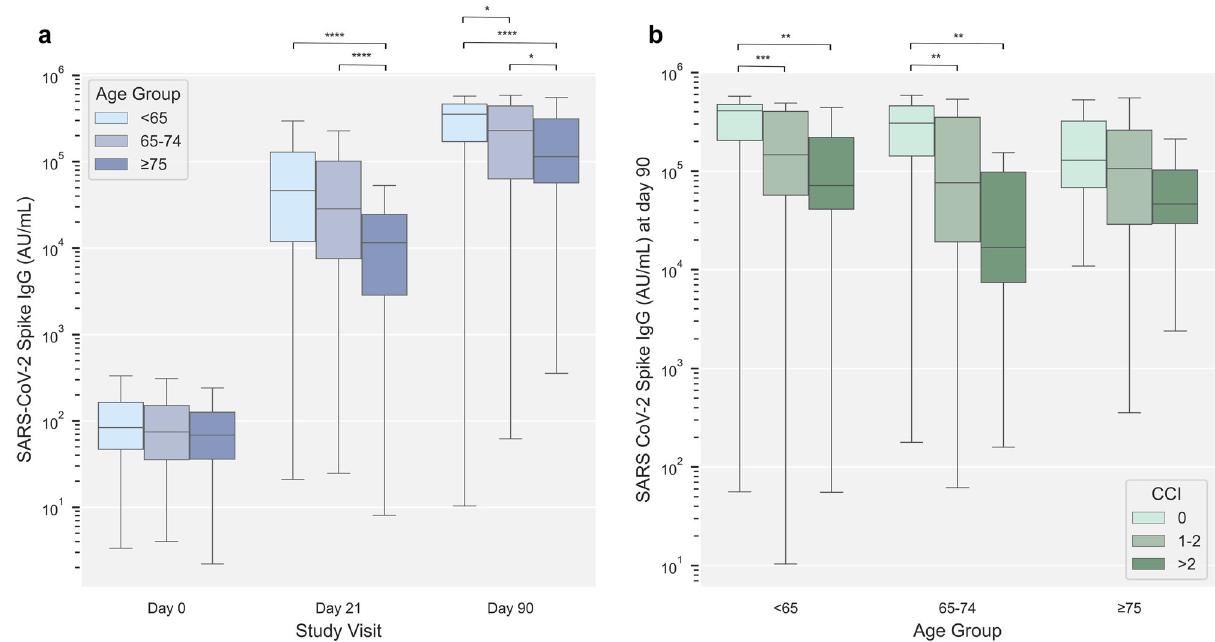
Fig. 3 SARS-CoV-2 Spike IgG by age and Charlson Comorbidities Index (CCI). a SARS-CoV-2 Spike IgG arbitrary units (AU)/ml at day 0, 21, and 90 strati fi ed by age group (<65 years [light blue], 65 – 74 years [blue], ≥ 75 years [dark blue]). Group sizes are; at day 0 n = 352 (<65 years), n = 154 (65 – 74 years), n = 144 ( ≥ 75 years); at day 21 n = 304 (<65 years), n = 152 (65 – 74 years), n = 142 ( ≥ 75 years); at day 90 n = 238 (<65 years), n = 146 (65 – 74 years), n = 139 ( ≥ 75 years). b SARS-CoV-2 Spike IgG at day 90 in the three age groups strati fi ed by Charlson Comorbidity Index (CCI) (CCI = 0 [light green], CCI = 1 – 2 [green], CCI > 2 [dark green]). Group sizes are; in age group <65 years n = 195 (CCI = 0), n = 33 (CCI = 1 – 2), n = 10 (CCI > 2); age group 65 – 74 years n = 92 (CCI = 0), n = 46 (CCI = 1 – 2), n = 8 (CCI > 2); age group ≥ 75 n = 97 (CCI = 0), n = 32 (CCI = 1 – 2), n = 10 (CCI > 2). Data was compared using unpaired, non-parametric Mann – Whitney U -test. Error bars show the distribution within 1.5 times IQR. p -value annotation legend: